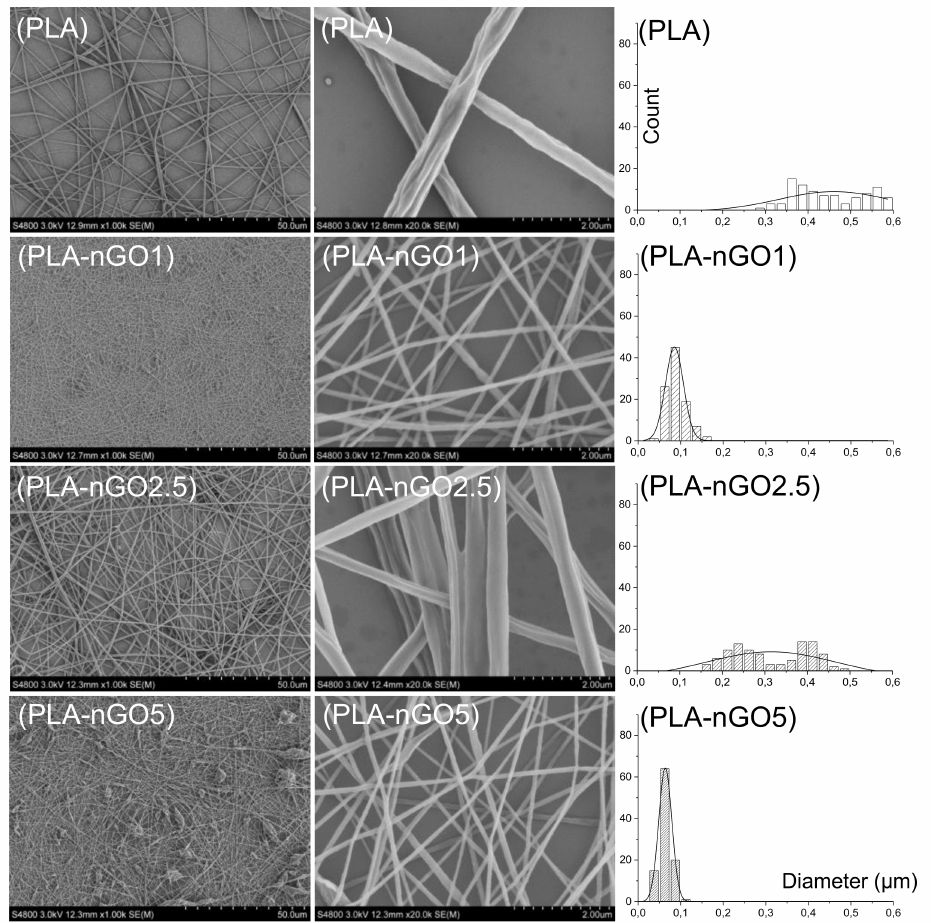
Figure 2. SEM images and the fiber size distribution of PLA, PLA-nGO1, PLA-nGO2.5, and PLA-nGO5 fibers.